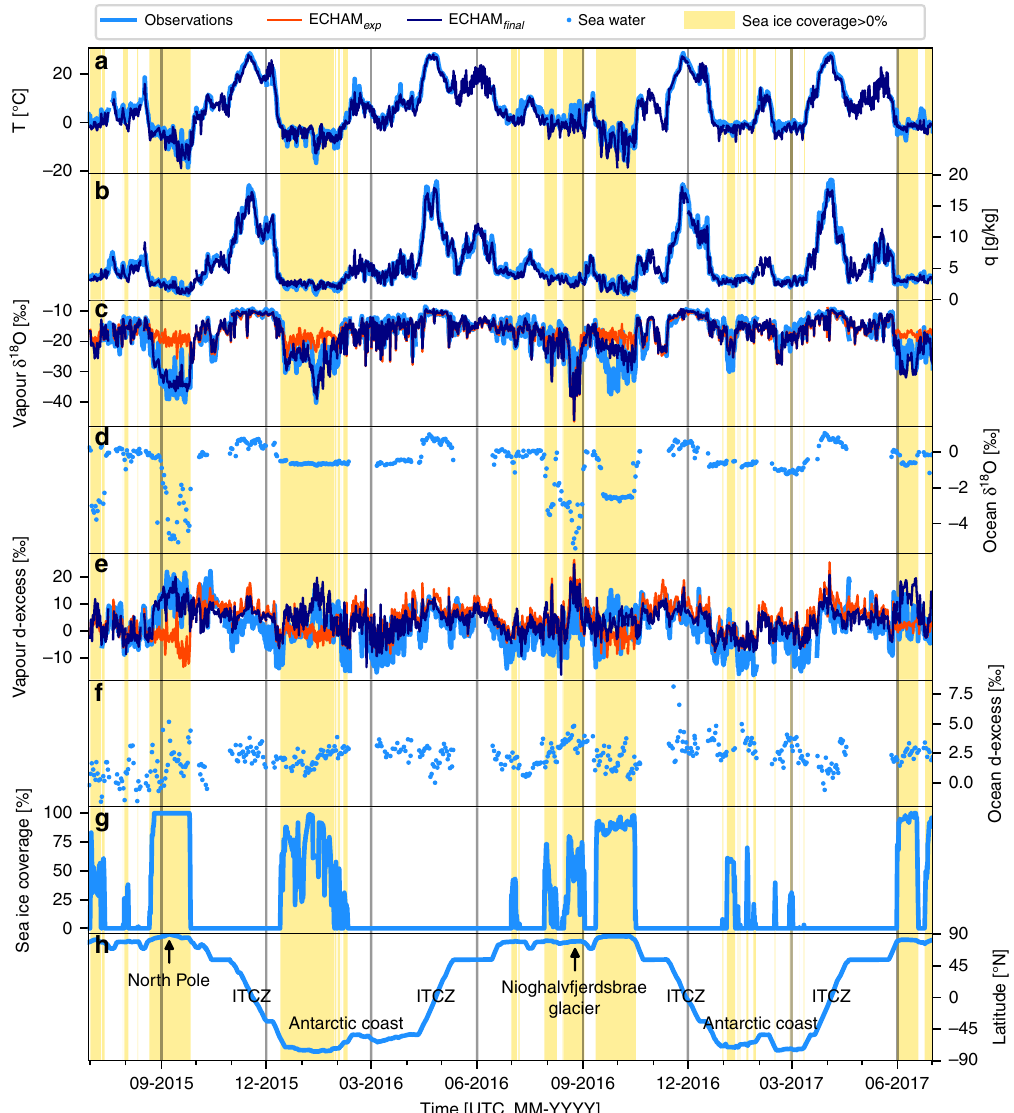
Fig. 1 Observed and modelled water vapour and its isotopic composition in the Atlantic sector. Isotope measurements on-board of the research vessel Polarstern at 6-h resolution during the period 29 June 2015 to 30 June 2017. a Air temperature T air (°C); b speci fi c humidity q (g kg − 1 ); c vapour δ 18 O ( ‰ ), d surface ocean water δ 18 O ( ‰ ); e vapour d-excess ( ‰ ); f surface ocean water d-excess ( ‰ ); g sea ice coverage (%); h latitude (° N). Pale yellow shades indicate periods with local sea ice coverage above 0%. For the air temperature, speci fi c humidity, vapour δ 18 O and vapour d-excess panels ( a , b , c and e ), results from the different isoGCM simulations (thin lines) are shown for comparison, with the dark blue lines for the ECHAM fi nal run and the orange lines for the ECHAM exp run. Note that both simulations give the same results for the temperature and speci fi c